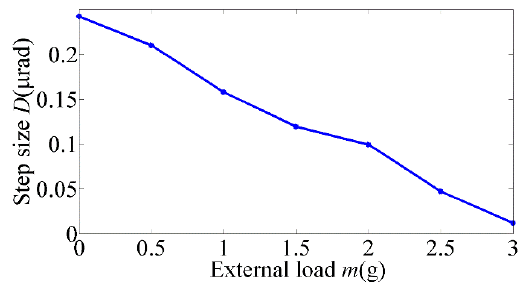
Figure 5. Relation of the external load and step size.